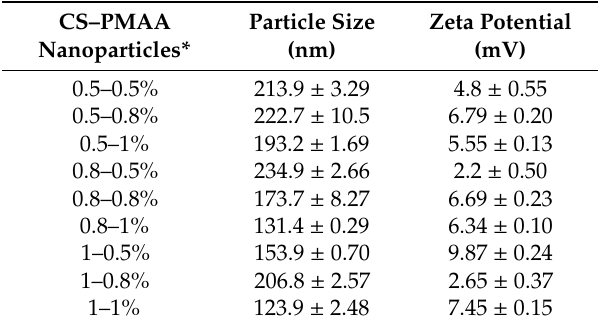
Table 1. Hydrodynamic diameter and zeta potentials of chitosan and poly (methacrylic acid) (CS–PMAA)